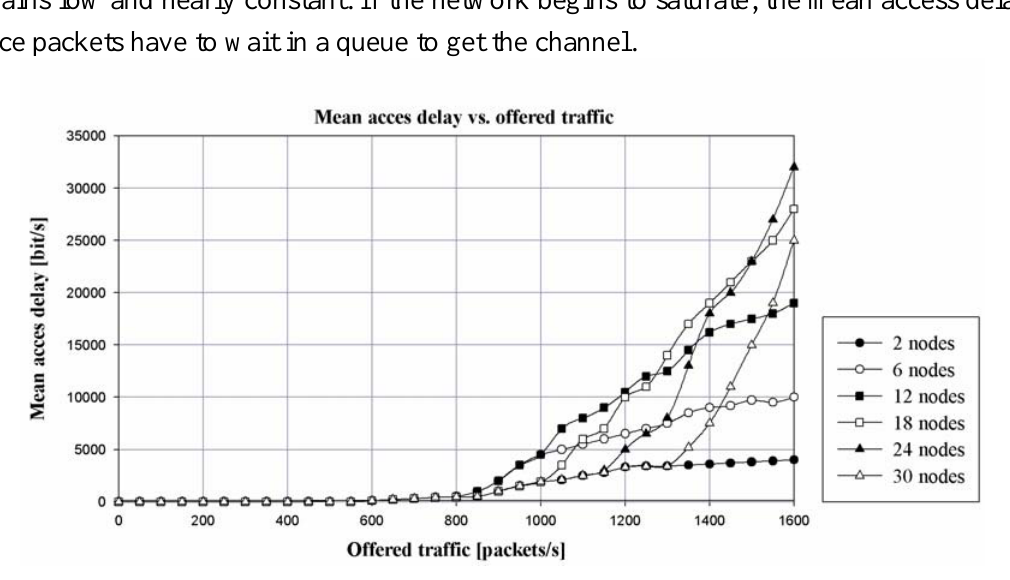
Figure 6. Mean access delay versus offered load for different number of nodes (load scenario